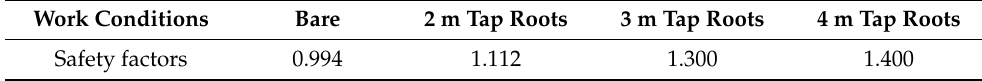
Table 3. Safety factors of different slopes.